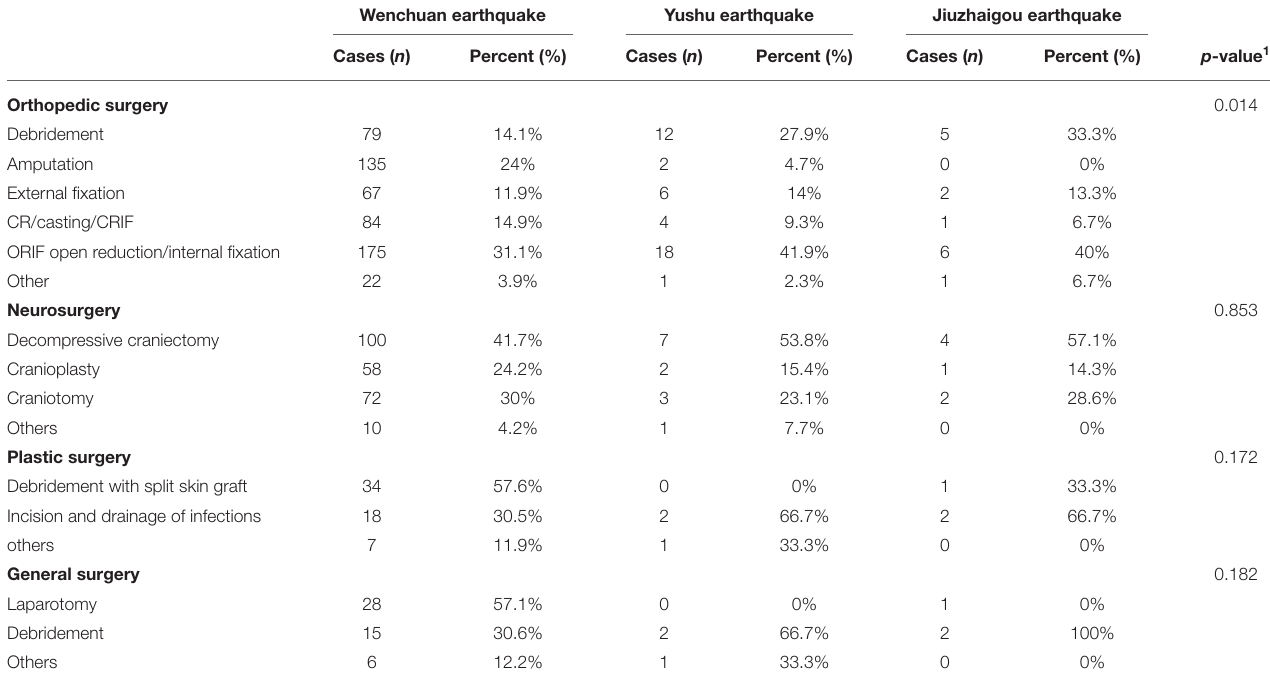
TABLE 3 | Comparison of the surgical treatment of earthquake patients from three large earthquakes. Wenchuan earthquake Yushu earthquake Jiuzhaigou